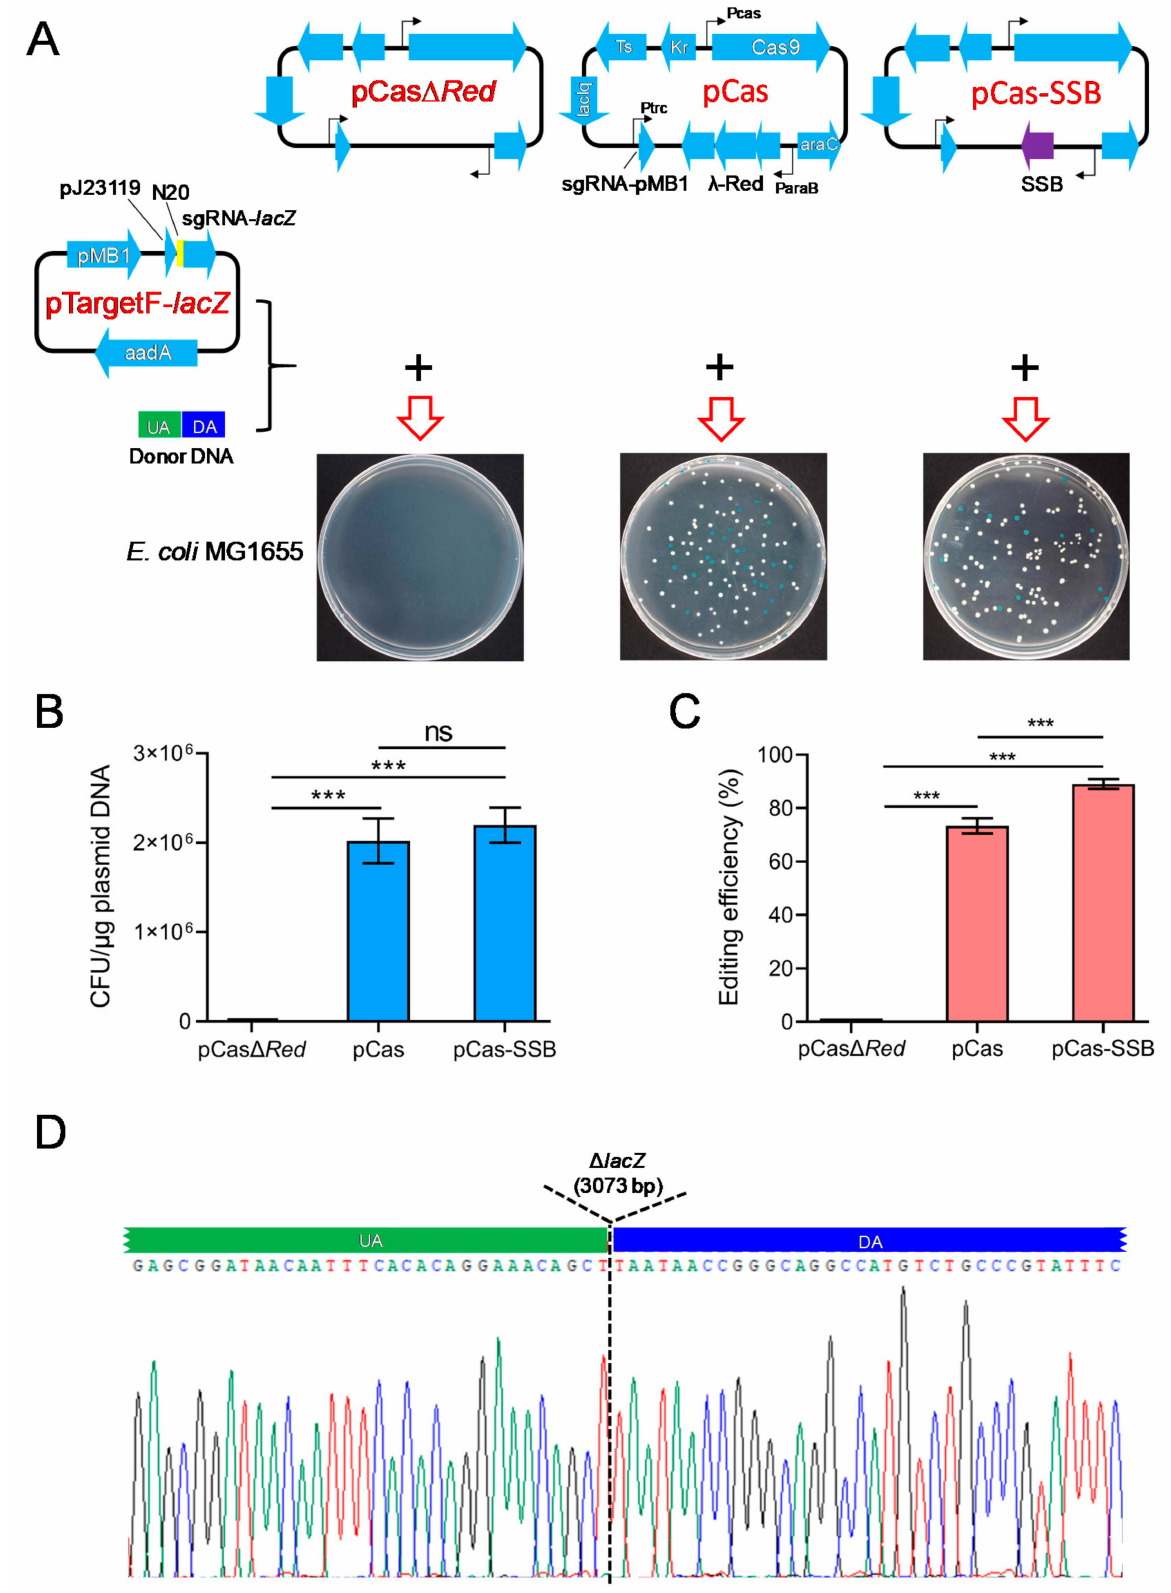
Figure 1. Comparison of CRISPR/Cas9 gene editing to delete the E. coli lacZ gene, assisted by SSB- and λ -Red recombination system-mediated HR repair of DSBs. ( A ) Schematic representation of the CRISPR-Cas9 two-plasmid system and the results of transforming the two plasmids into E. coli